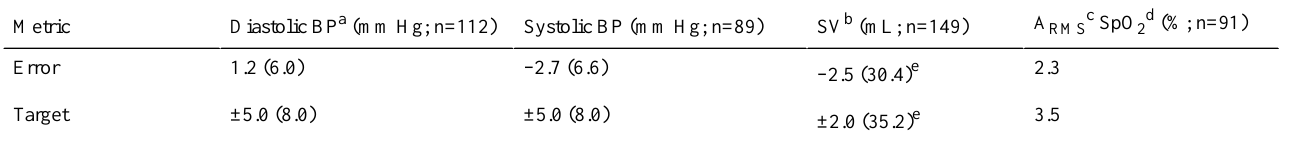
Table 3. Principal results for each of the seat measures compared to their respective clinical gold